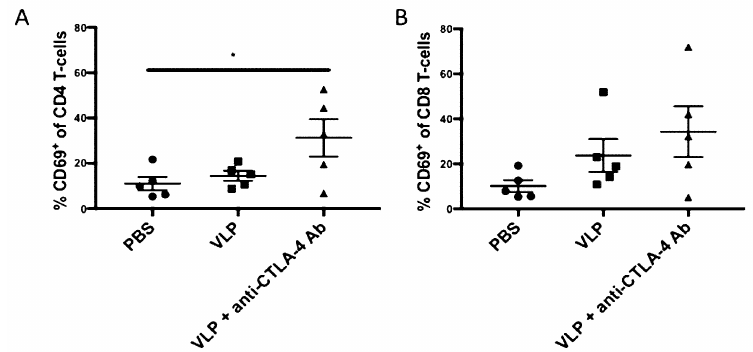
Figure 1. CTLA-4 blockade enhances CD4 T-cell activation. Splenocytes from Cohort 1 were harvested 10 days after receiving their second virus-like particle (VLP) dose, and 4 days after receiving their final injection of anti-CTLA-4 Ab. CD3+ T-cells were pre-gated and CD4 and CD8 discrimination gating was performed (Figure S2A). Cumulative results from all animals are shown for ( A ) CD4+ CD69+ T-cells and ( B ) CD8+ CD69+ T-cells. Statistical significance was determined using a one-way ANOVA and Tukey post-hoc analysis for multiple comparisons. A line on top of two groups indicates statistical differences between these two groups. * p < 0.05.